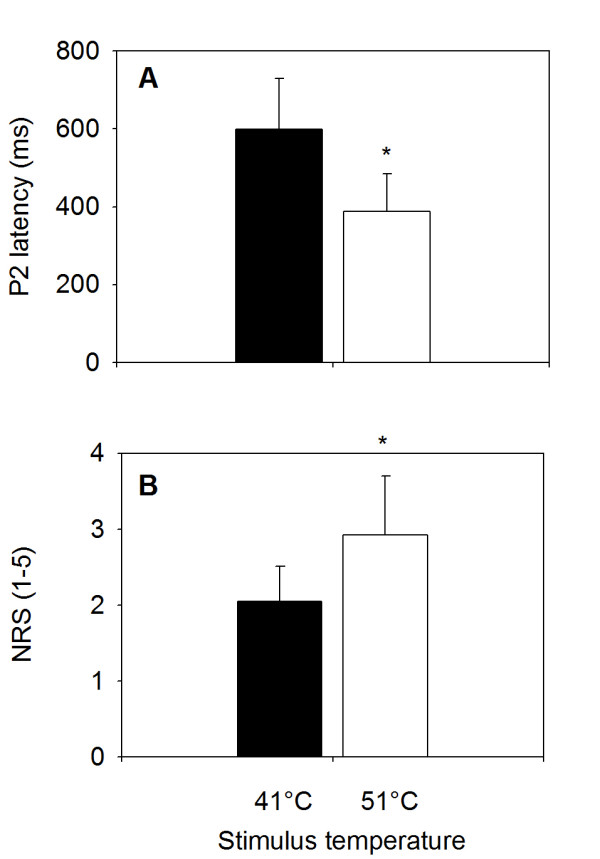
Latency of major positive peak and pain intensity (NRS). A) Latency of the first major positivity in the heat-evoked potential at the vertex (electrode Cz). Latency of 51°C stimuli were significantly shorter than latency of 41°C stimuli (*p = 0.04). B) Average pain intensity ratings obtained during scanning. Ratings of 51°C stimuli were significantly more intense than ratings of 41°C stimuli (*p = 0.018). Values are mean ± standard deviation.